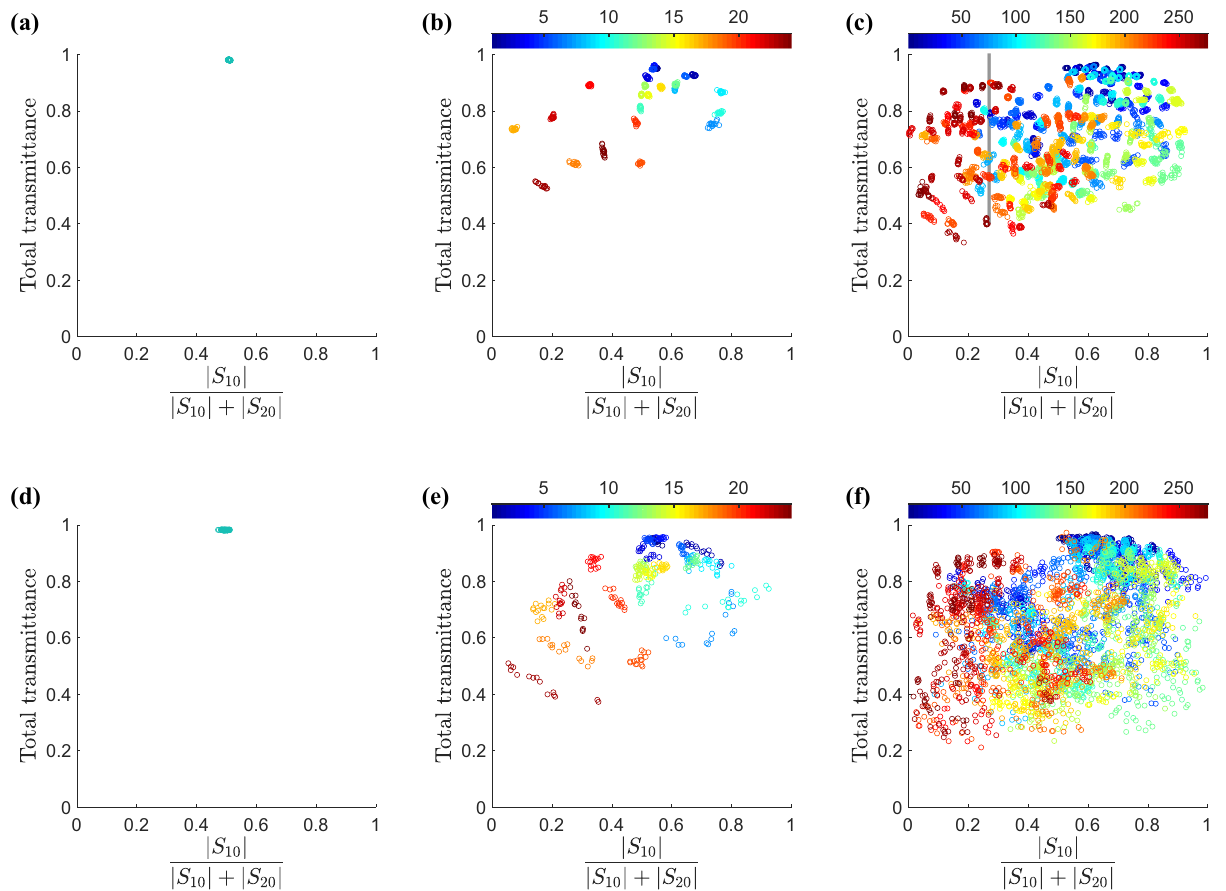
Figure 4. Total transmittance of symmetrical power divider versus division ratio for different vias distribution. Randomly vias patterns are considered for three combinations of hybrid PEC/air vias patterns shown in the first three figures: ( a ) only air vias without any PEC vias and 360 bunch simulations for the position of air vias. ( b ) air vias pattern combination with only one PEC via. The PEC via is located in 24 (C(24, 1) = 24 ) possible positions depicted by different colors. ( c ) air vias pattern combination with two PEC vias. The two PEC vias are located in 276 (C(24,2) = 276) possible positions depicted by different colors. Also, the three modes of hybrid PEC/ dielectric vias patterns are in the second row of the figure. ( d ) 360 bunch simulations for dielectric vias pattern without any PEC vias. ( e ) dielectric vias pattern combination with only one PEC via. ( f ) dielectric vias pattern combination with two PEC via. For each position of PEC vias, consider 15 bunches of air vias position that show in the group by similar